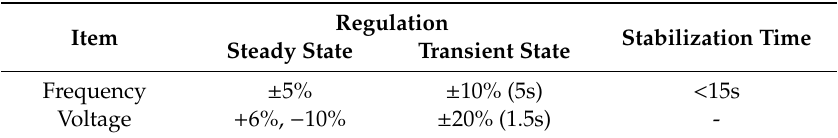
Table 9. Rules for the classification of electrical installation and control systems of the Korean Register of Shipping.